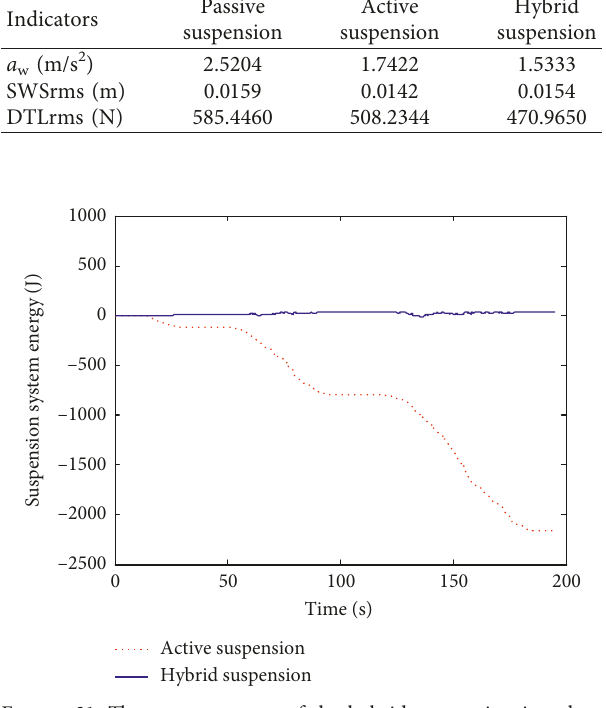
Figure 21: The system energy of the hybrid suspension in urban circulation units.